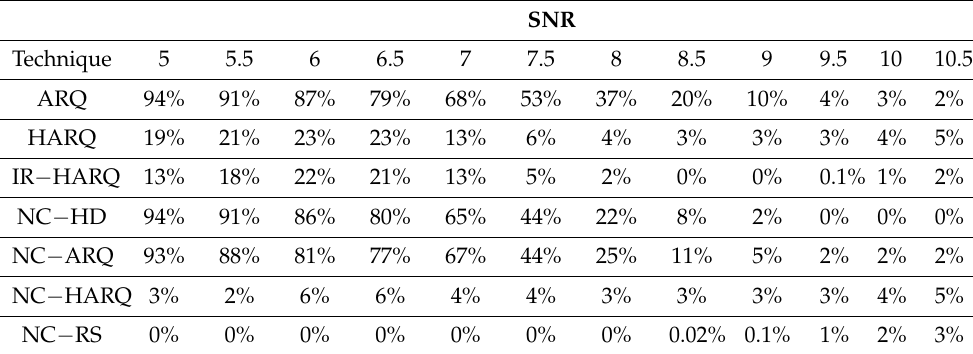
Figure 6. AC2NC FDD transmission mode.